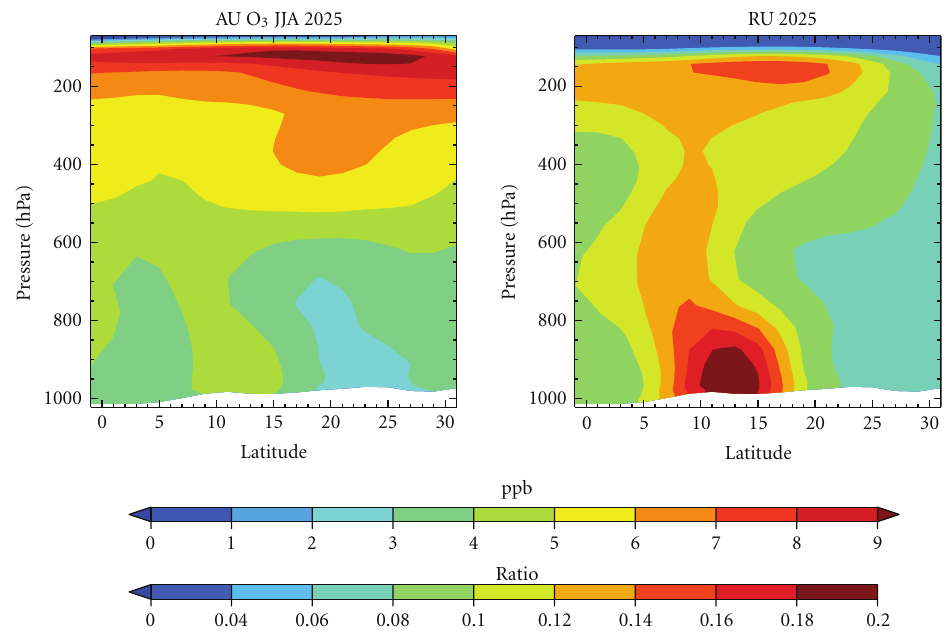
Figure 5: The zonal seasonal mean AU and RU between the A1 and B1 emission scenarios for 2025 during JJA. The uncertainty ratio represents the 1 − σ variability weighted by the zonal seasonal mean distribution of tropospheric O 3 for 2003.